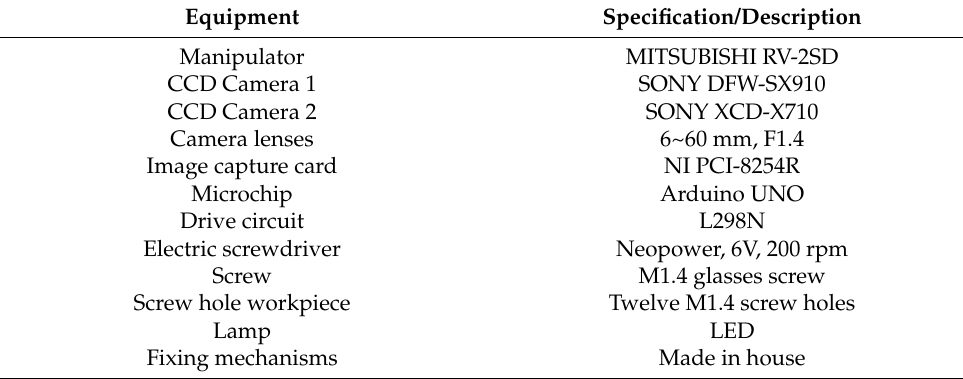
Figure 3. Experiment platform. Table 1. Equipment